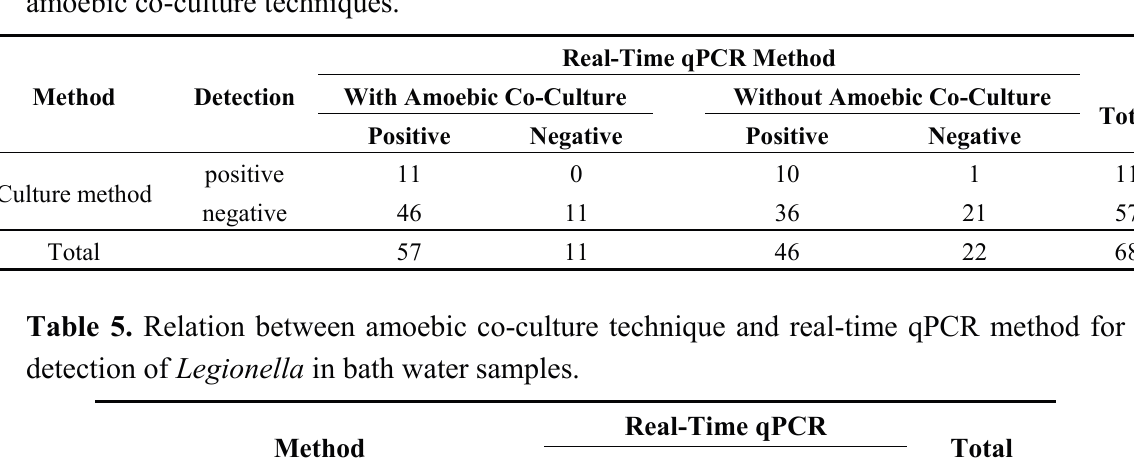
Table 4. Comparison between the culture and real-time qPCR methods with or without amoebic co-culture techniques.